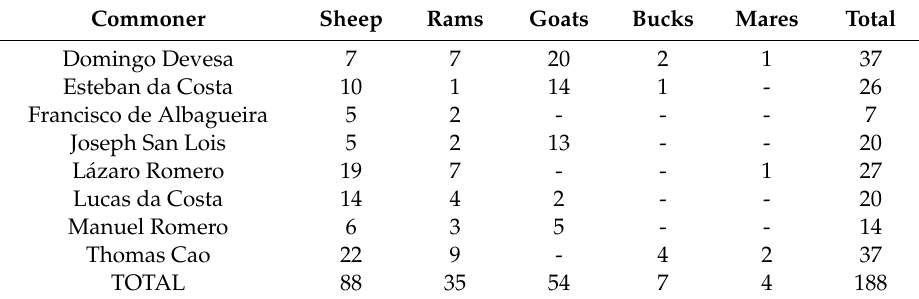
Table 1. Livestock per household in Froj á m according to the 1753 census 1 . Commoner Sheep Rams Goats Bucks